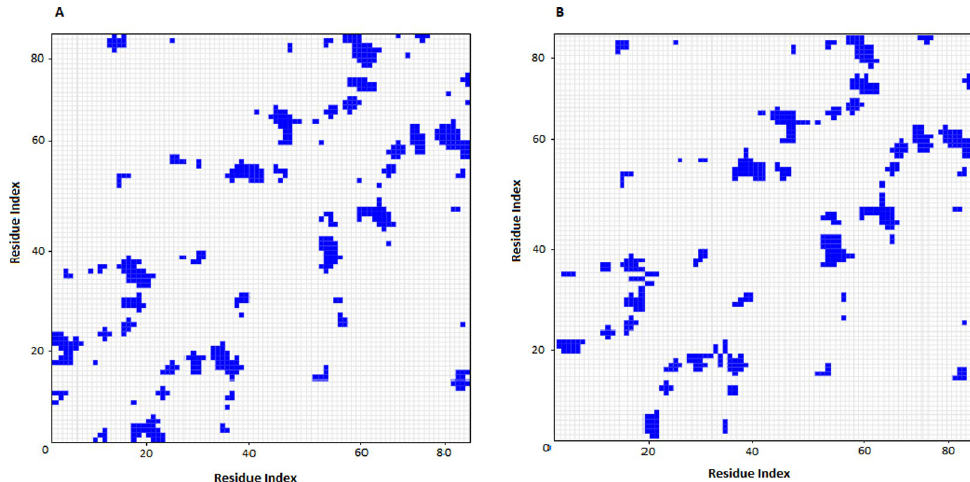
Fig 8. Protein contact map between UDA and RBD at 0 ns (a) and 100 ns (b) of molecular dynamic simulation.